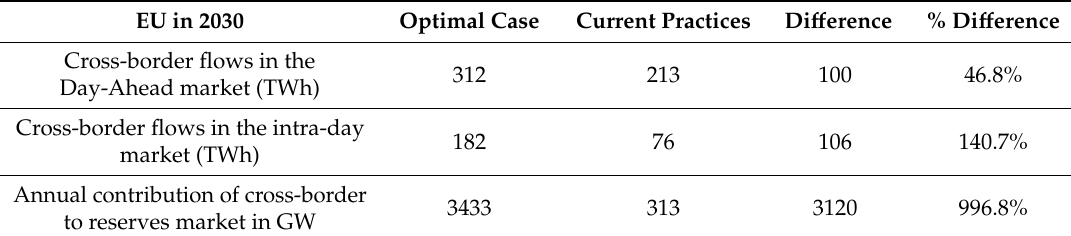
Table 6. Role of cross-border